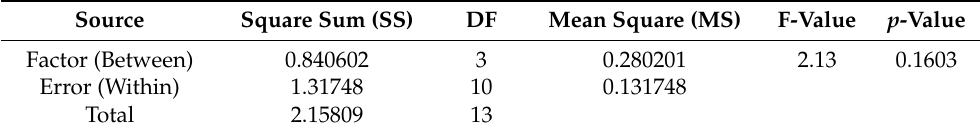
Table 12. Effect of P1 fiber type and temperature on f R,a by applying ANOVA analysis.